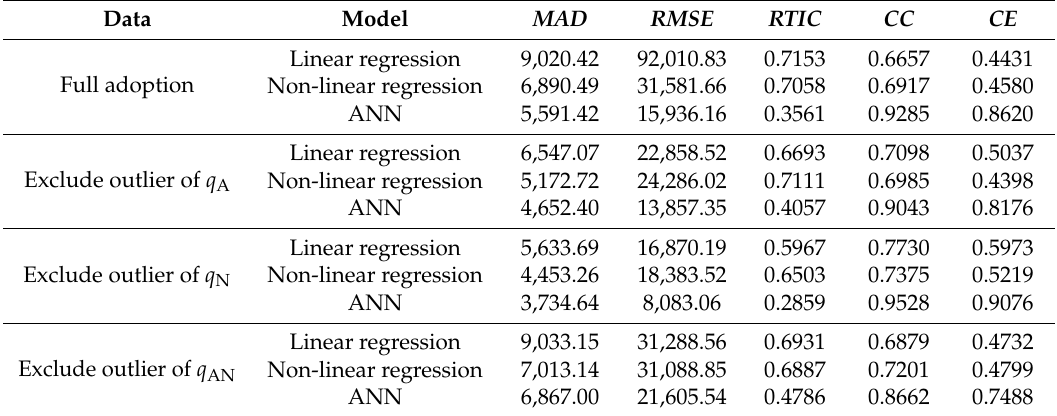
Table 4. Performance comparison of each water demand model with full or partial